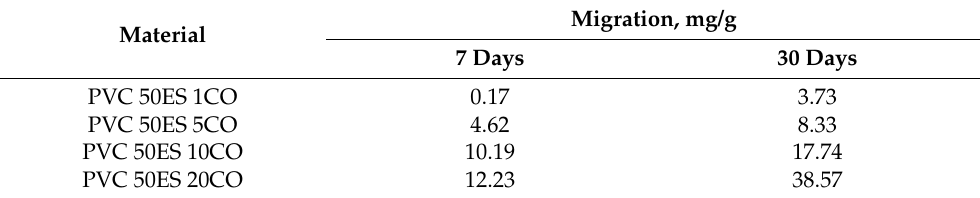
Figure 9. Analysis of peak area changes at 1700 cm − 1 –1650 cm − 1 of the PVC 50ES 20CO sample as a function of migration time (0, 7, and 30 days).